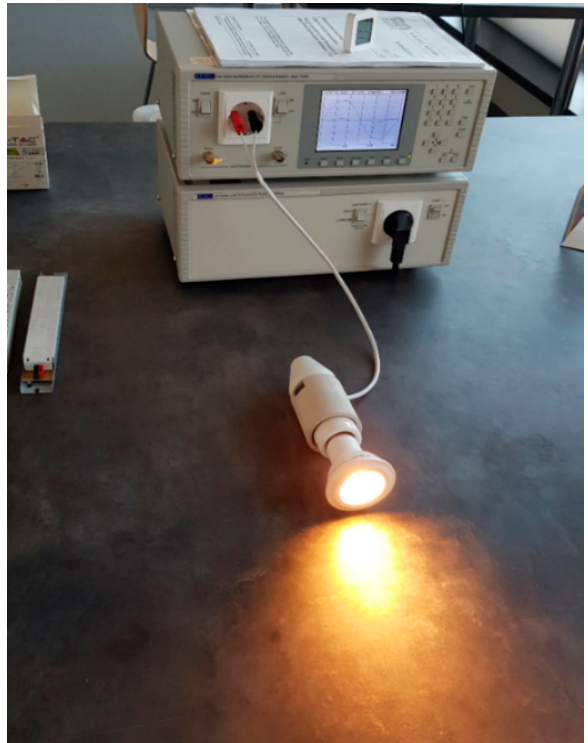
Figure 3. Photo of the measuring station with the tested source V-TAV PRO 7W E-27 .